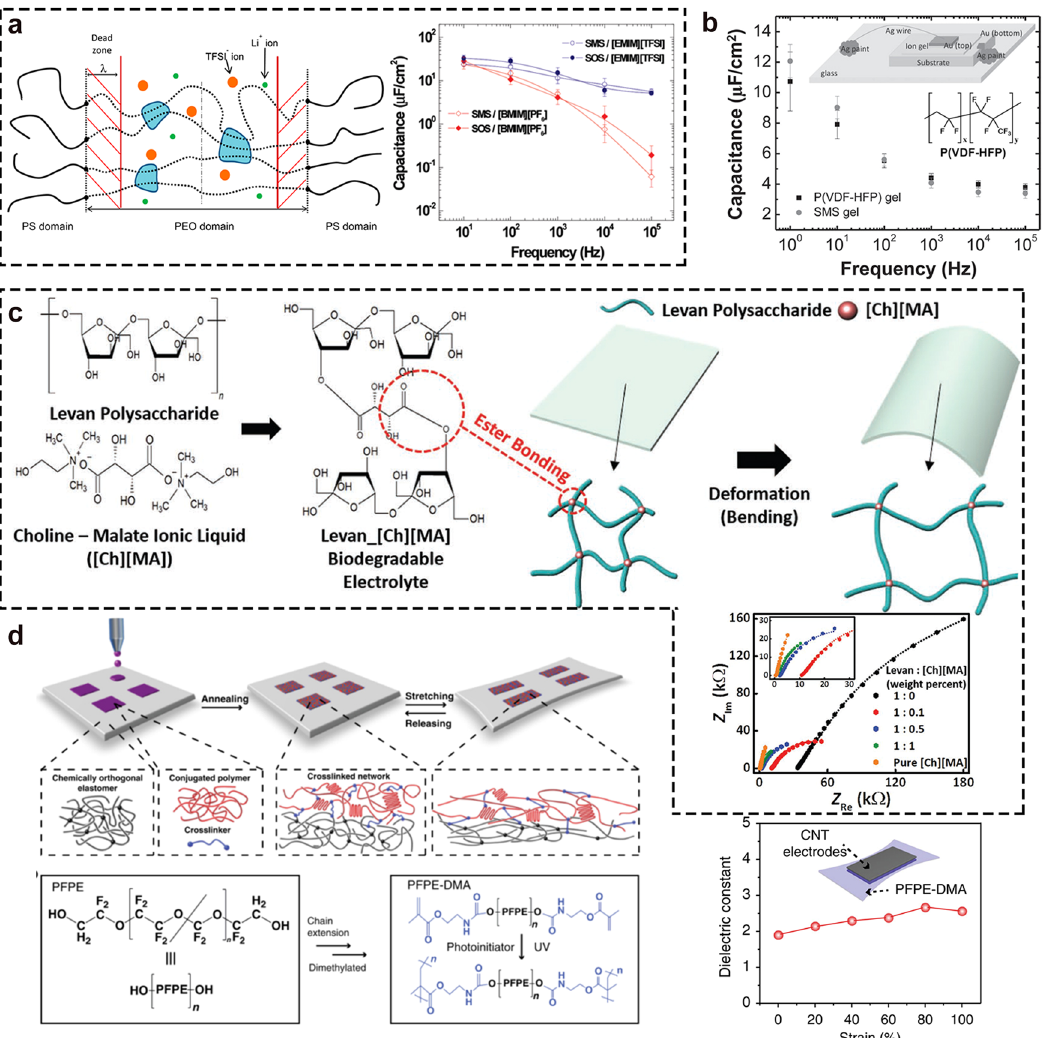
Fig. 3 Four different types of polymer materials used for an ionic-gel transistor. a SOS, a schematic diagram of the structure of a triblock (ABA) polymer. Reproduced with permission 131 . Copyright 2014, American Chemical Society. Capacitance-frequency dependence of four different ionic-gel. Reproduced with permission 53 . Copyright 2009, American Chemical Society. b Comparison of the frequency dependence curves of the maximum capacitance of SMS and P (VDF-HFP) materials. The inset is a schematic diagram of the molecular structure and device structure of P(VDF-HFP). Reproduced with permission 56 . Copyright 2012, Wiley-VCH. c The molecular structure of Lewandan, the synthetic ionic liquid based on choline and malate ions, and the chemical structure and schematic diagram of the expected synthesized LSE membrane. On the below side is the Nyquist chart of LSE. Reproduced with permission 59 . Copyright 2020, Wiley-VCH. d The schematic diagram shows the material design used to pattern stretchable transistors on elastomer dielectrics by inkjet printing. The fi gure on the right shows the dielectric constant of the PFPE-DMA fi lm subjected to uniaxial strain. Reproduced with permission 69 . Copyright 2020, Springer